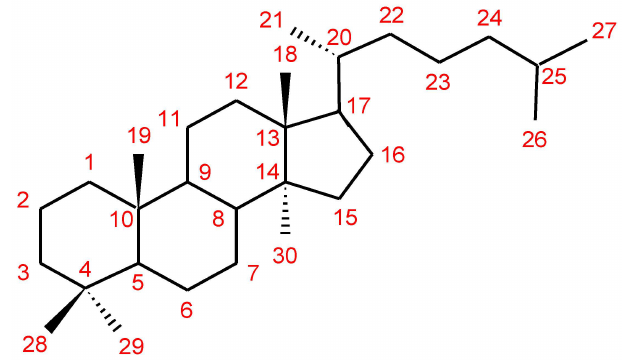
Figure 2. Chemical structure of lanostane